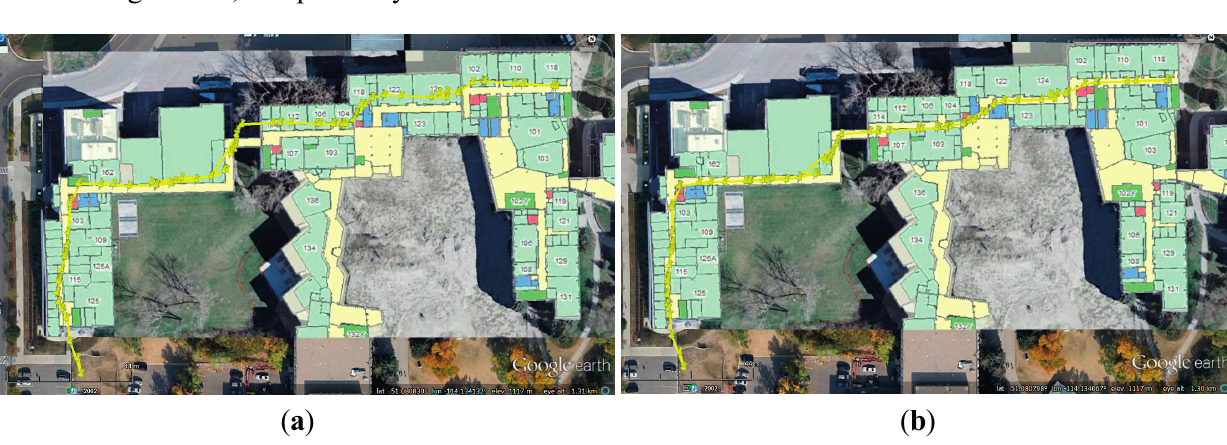
Figure 18. WiFi fingerprinting result using proposed DB ( a ) and that using reference DB ( b